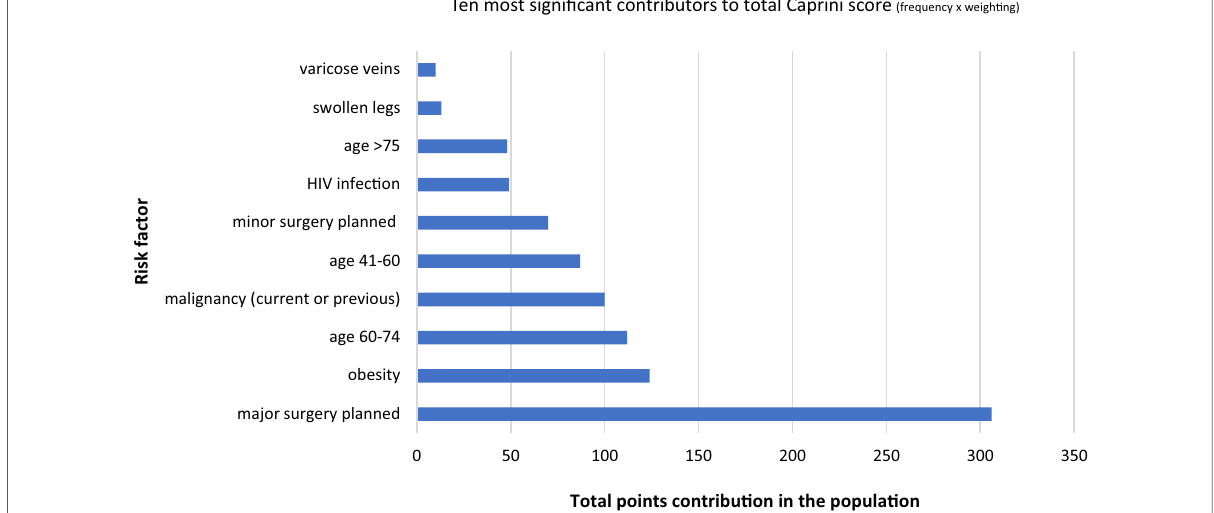
Fig. 4 Most clinically significant risk factors in the sample population considering frequency and